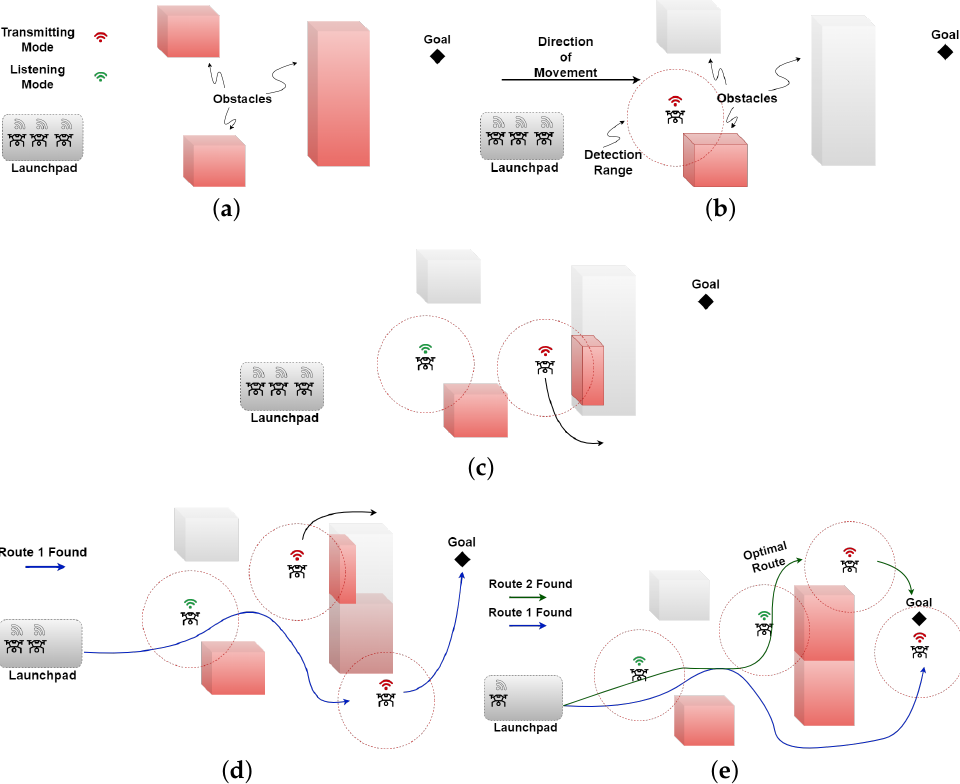
Figure 1. Illustration of DCP-SLAM technique. Unknown obstacles are illustrated in grey. Once an obstacle (or a part of it) is detected by the onboard sensors of the robot(s), it is illustrated in red. ( a ) Initial setup, launchpad where robots are launched from and unknown obstacles are shown. ( b ) Robot 1 detects an obstacle while navigating towards goal. Robot 1 broadcasts the information to following robots. ( c ) Partial detection of second obstacle by Robot 1, Robot 2 navigating towards the waypoint dropped by Robot 1. ( d ) Robot 1 finds unobstructed path to goal, Robot 2 navigates from the other side of the obstacle, while broadcasting the information. ( e ) Robot 2 finds unobstructed path to goal. Followers opt for the optimal